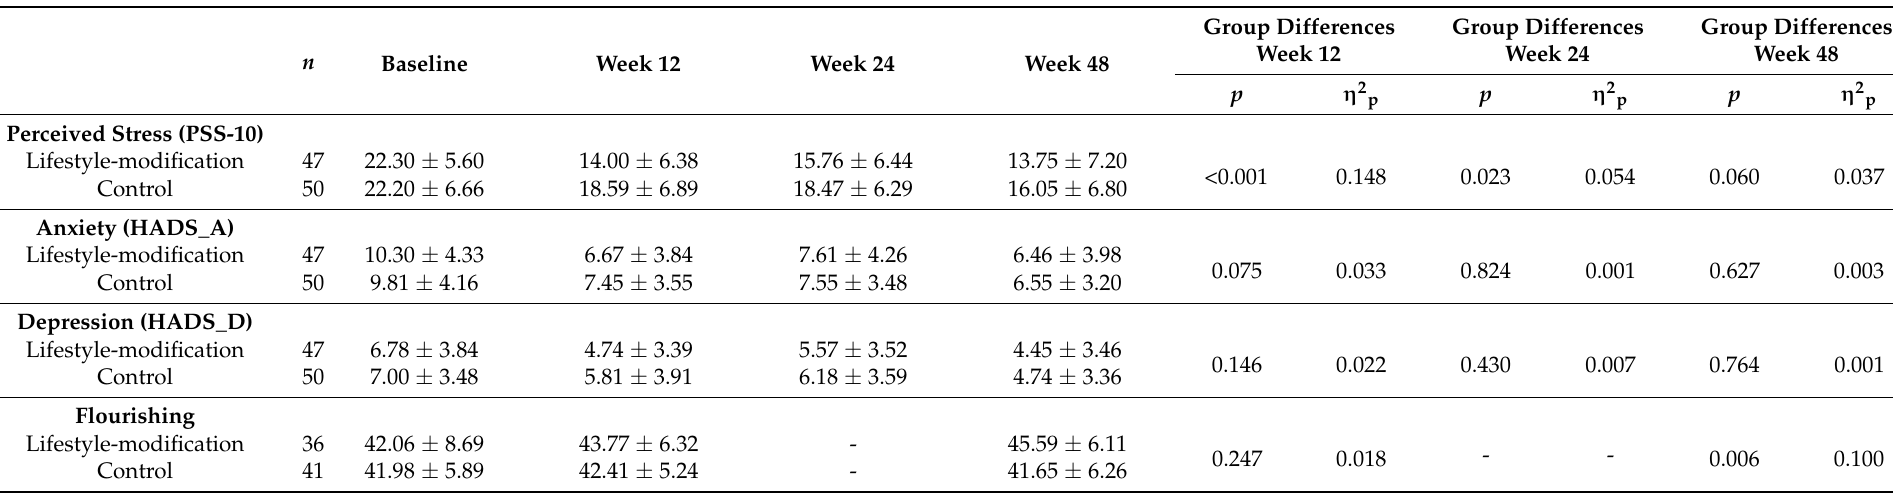
Table 2. Long-term effects of the comprehensive lifestyle-modification program on stress, anxiety, depression and flourishing (mean ± standard deviation